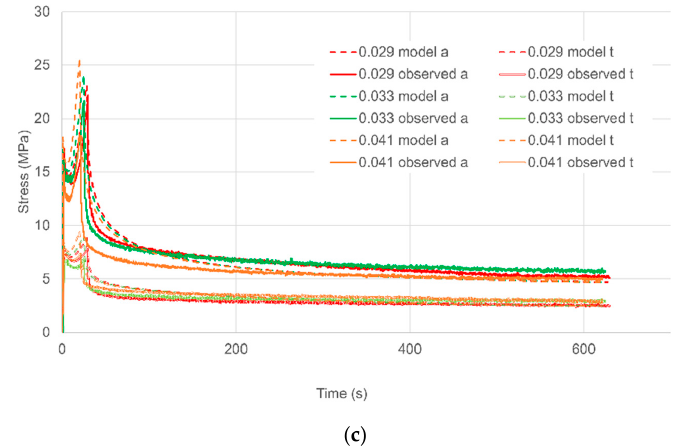
Figure 11. Planar loading and relaxation. The key shows octahedral strain rates in s − 1 and also identifies axial and transverse stress (a and t respectively). ( a ) the three lowest, rates; ( b ) three intermediate rates and ( c ) three highest rates.